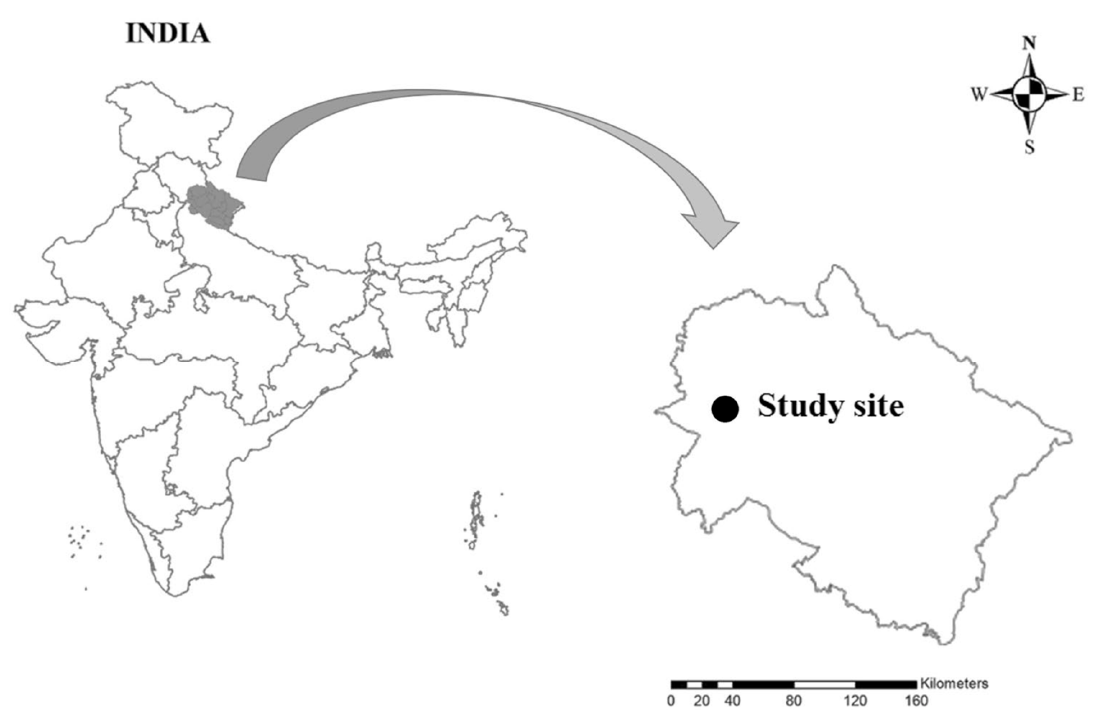
Figure 1. Location of the study site.